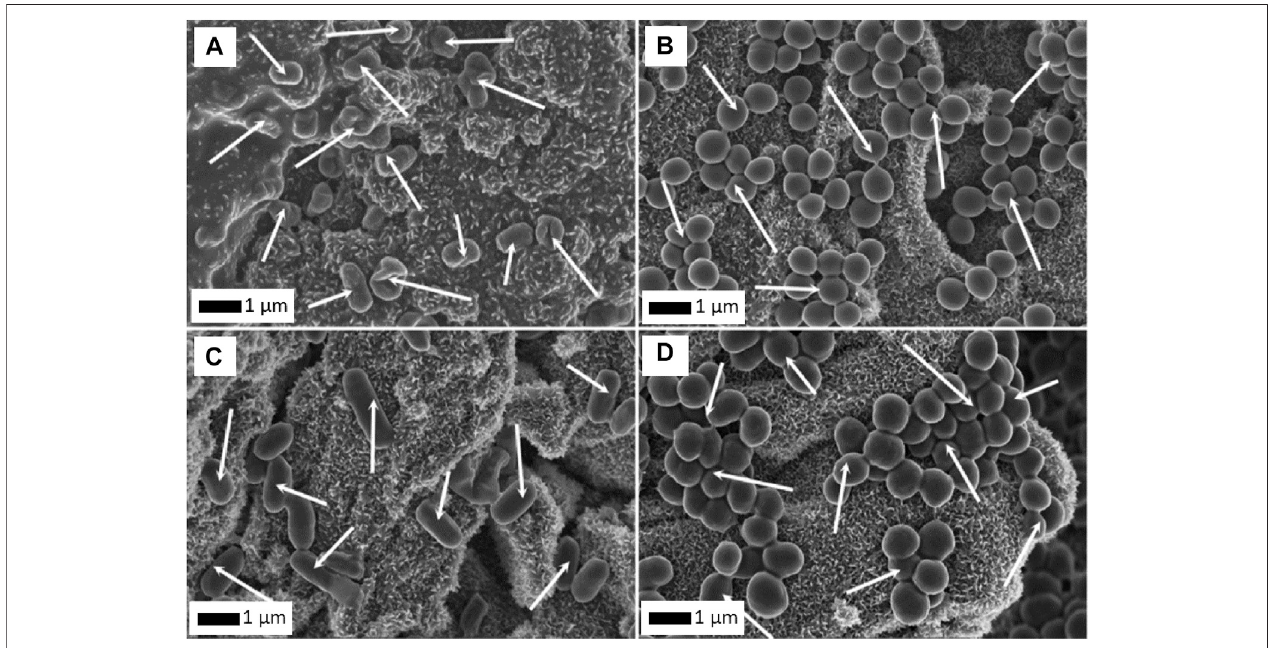
FIGURE 12 | Biosorption of E. coli (A) , S. aureus (B) , Bacillus sp . (C) and Sarcina (D) cells on the surface of RGO/Al 2 O 3 -Au nanocomposite. Arrows point to bacterial cells (Reproduced with permission from (Jastrze ˛ bska et al., 2017e) with minor changes).